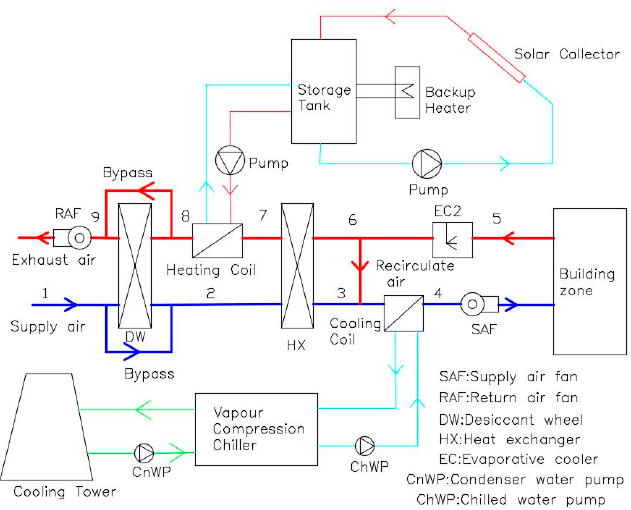
Figure 7. Schematic diagram of the SDCC system.